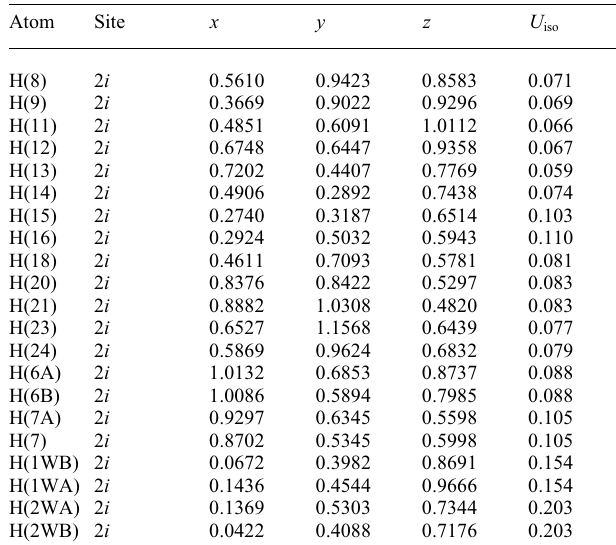
Table 1. Data collection and